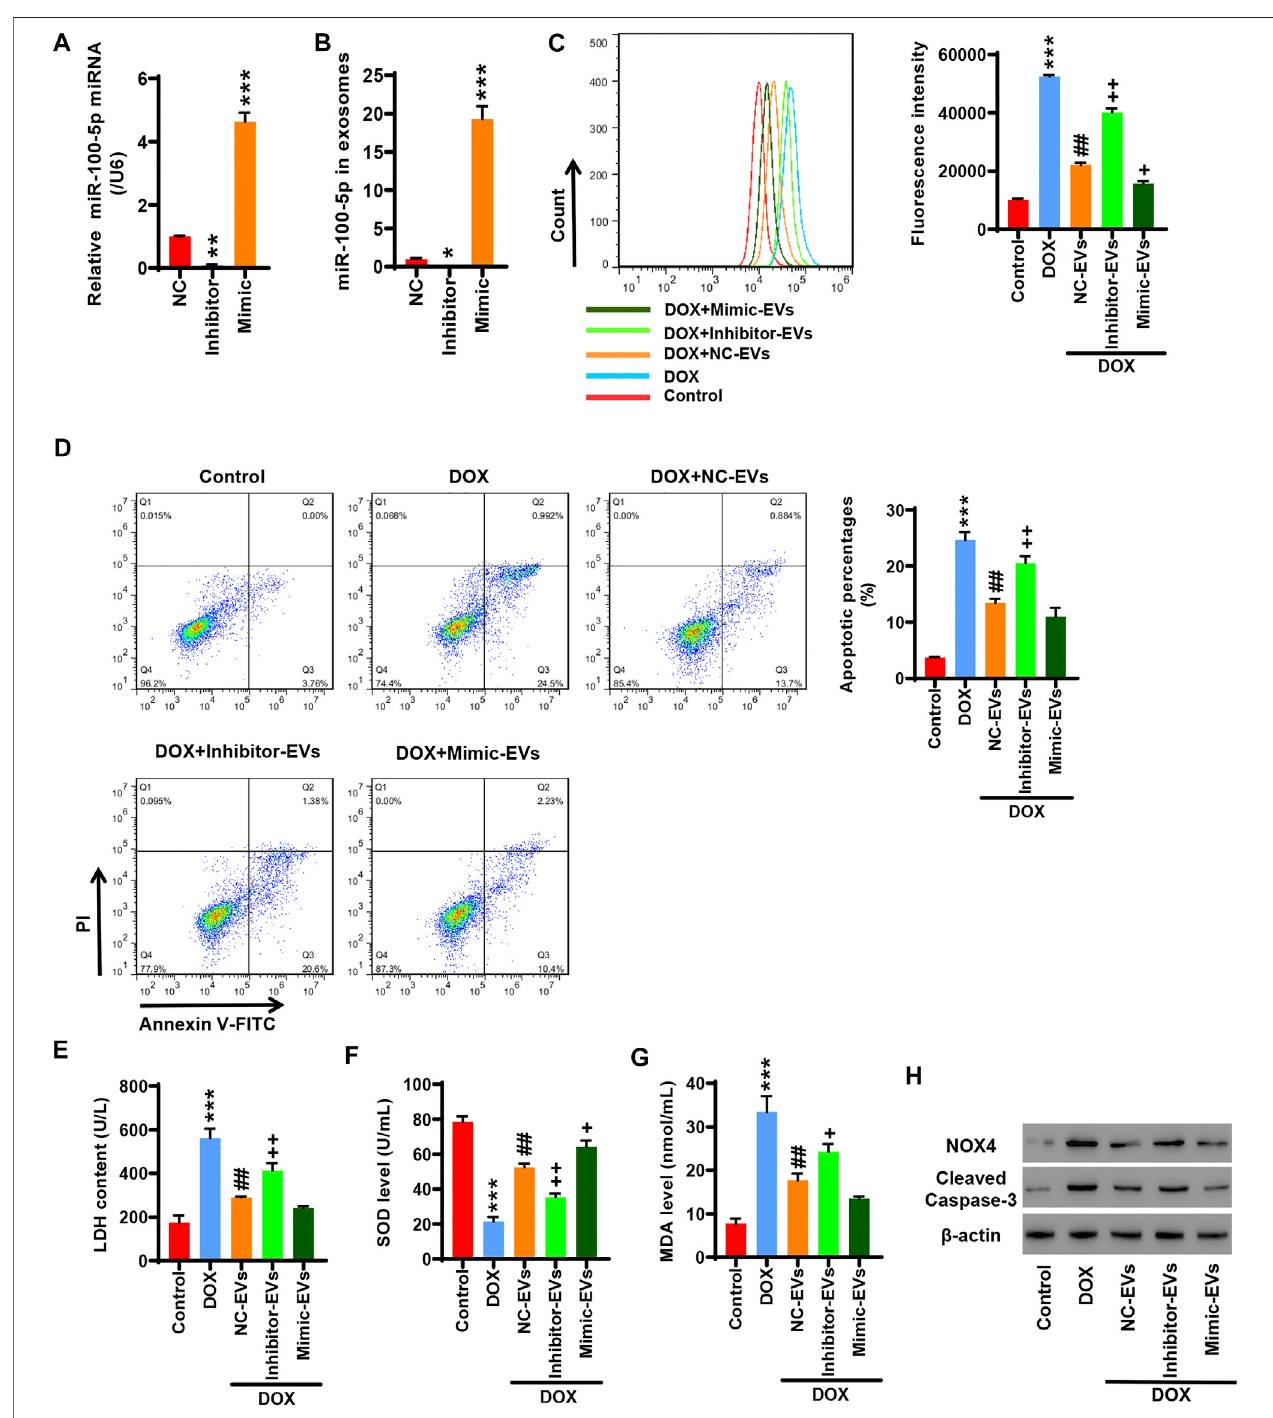
FIGURE 4 | Inhibition of EV miR-100-5-p reverses the effects in which HucMSC-EVs inhibit DOX-induced oxidative stress and apoptosis. (A) HucMSCs were transfected withmiR-100-5p inhibitor (Inhibitor)or miR-100-5p mimic (Mimic).MiR-100-5p expression wasdetermined byQ-PCR. (B) HucMSCswere transfected with miR-100-5p inhibitor or miR-100-5p mimic. After HucMSC-EVs were extracted, EV miR-100-5-p was determined by Q-PCR. * p < 0.05, ** p < 0.01, *** p < 0.001 vs. NC. (C – H) AC16cellsweretreatedwith2 µmol/LDOXandEVmiR-100-5pinhibitor (Inhibitor-EVs)orEVmiR-100-5-pmimic (Mimic-EVs) ataconcentrationof100 µg/ ml. (C) ROSlevelsweremeasuredby fl owcytometry. (D) Apoptosiswasdeterminedby fl owcytometry.Quadrant1representeddeadcells.Quadrant2representedlate apoptotic cells. Quadrant 3 represented early apoptotic cells, and Quadrant 4 represented normal cells. (E – G) LDH, SOD, and MDA levels were measured with biochemical assay. (H) NOX4 and cleaved-caspase-3 expression were examined by Western blot. *** p < 0.001 vs. control, ## p < 0.01 vs. 2 µmol/DOX, + p < 0.05, ++ p < 0.01 vs. 2 µmol/L DOX + NC-EVs.